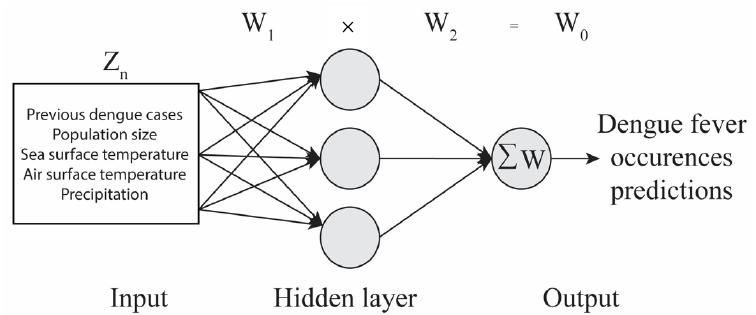
Figure 2. Artificial neural networks (ANNs) schematic. Example of an ANN schematic showing the input layer, hidden layer, and output layer. ANNs calculate weights from variables (Z n ) in the input to hidden layer (W 1 ). The hidden layer then combines these weights and calculates a new set of weights (W 2 ). The neural pathway strengths (W 0 ) are then calculated, with the equation above the schematic (W 1 × W 2 = W 0 ), to obtain the strength of influence to predict outcomes, following Duncan et al. [51] and Duncan [56].